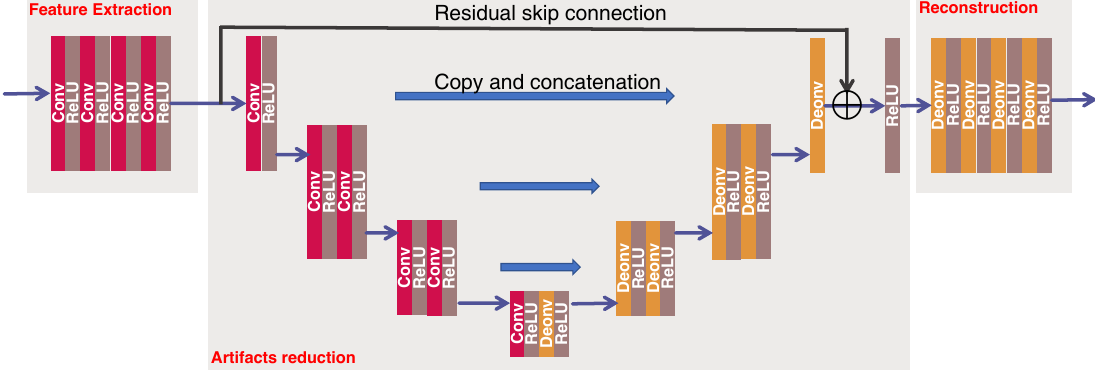
Figure 2. The proposed network structure for reflection artifacts correction. It comprises three parts—feature extraction, artifacts reduction, and reconstruction. In particular, we use a modified version of U-net as the backbone of artifacts reduction